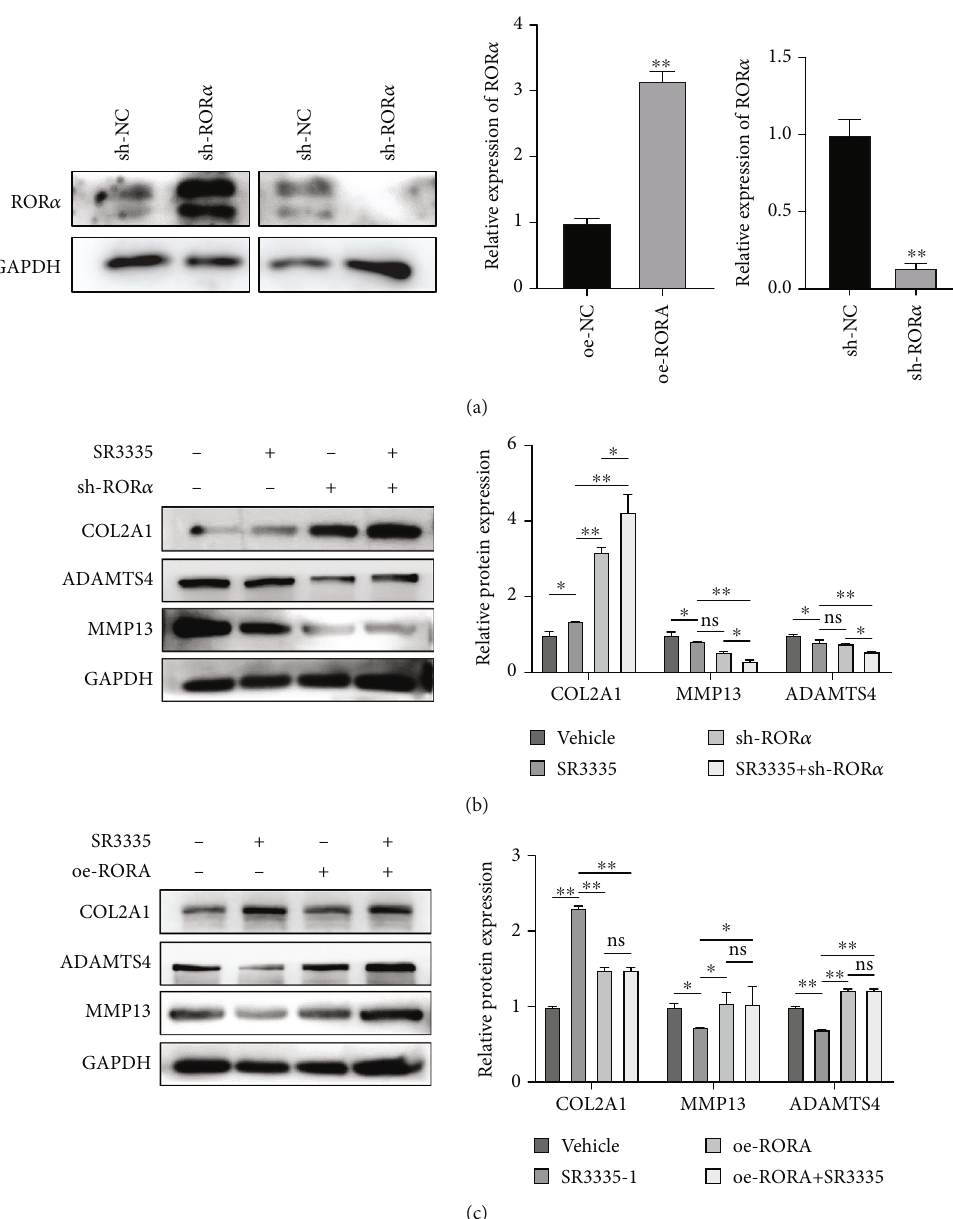
Figure 6: The anticatabolism and proanabolism e ff ect of SR3335 is mediated by interaction with ROR α . (a) The expression of ROR α protein after being transfected with RORA overexpression or sh-RORA lentivirus was measured with western blot. (b) The NP cells were transfected with sh-RORA lentivirus and 1 μ M of SR3335. The protein level of COL2A1, MMP13, and ADAMTS4 was assayed by western blot and quanti fi cation. (c) The NP cells were transfected with RORA overexpression lentivirus and 1 μ M of SR3335. The protein level of COL2A1, MMP13, and ADAMTS4 was assayed by western blot and quanti fi cation. All experiments were repeated three